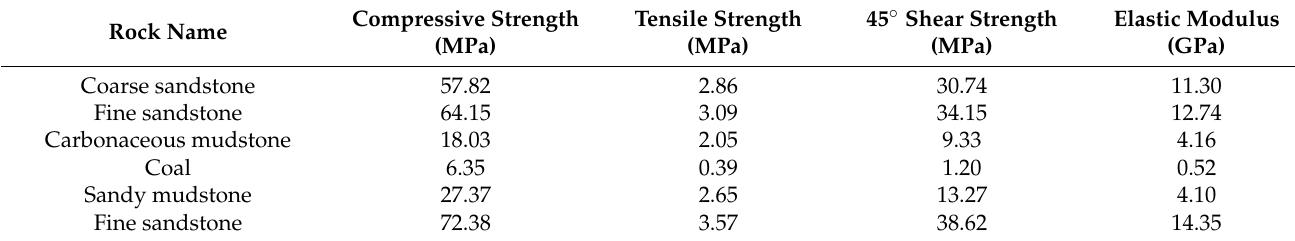
Table 2. Main rock mechanical strength of roof and floor of VI 13 coal seam.